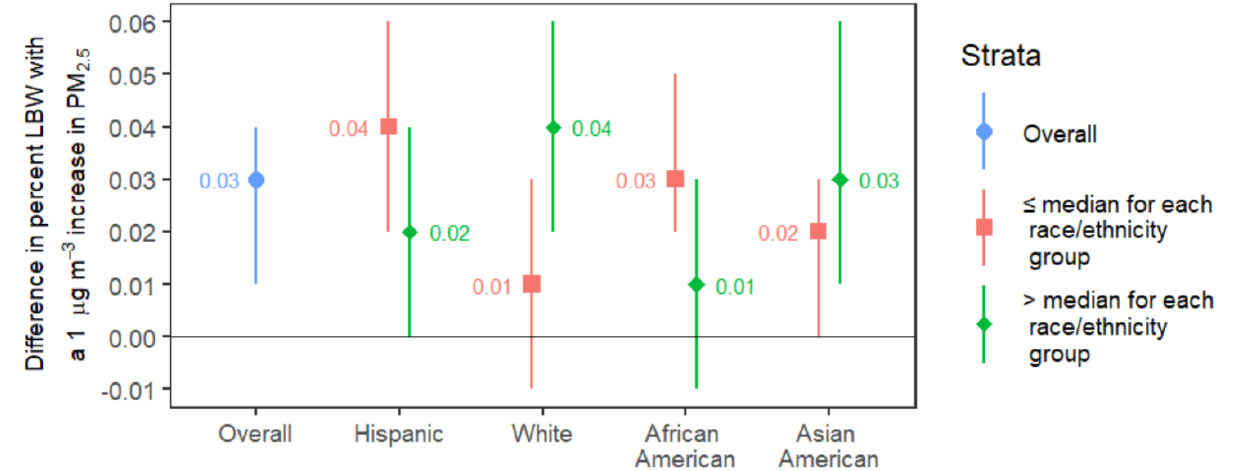
Figure 3. Percent change in low birth weight per 1 µg m -3 change in PM 2.5 stratified by median race/ethnicity in California census tracts. The central points are the estimates of percent LBW associated with a 1 µg m -3 difference in PM 2.5 , and the whiskers demonstrate the 95% confidence intervals for these estimates. All models adjusted for the other race/ethnicity groups, poverty and toxic re- American: 2.6%, Median % Asian American: 8.2%. Numeric results are in Supplemental Material, Table